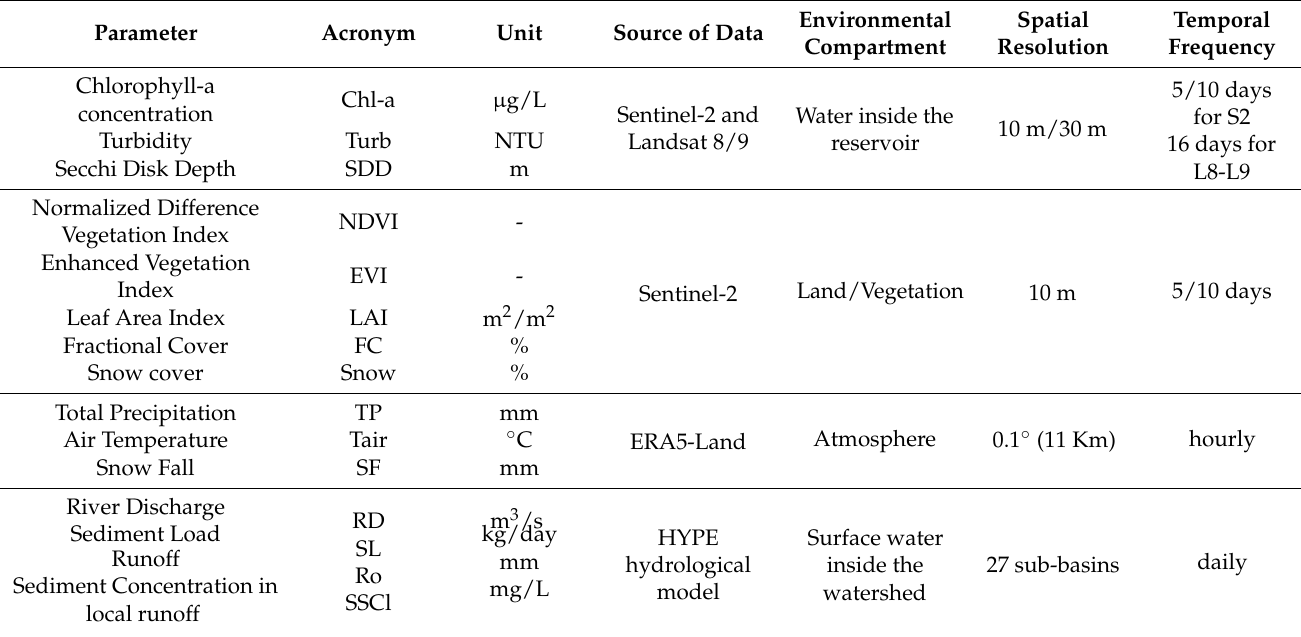
Table 1. List of the used parameters, with relative units, source of data, environmental compartment described, and spatial/temporal